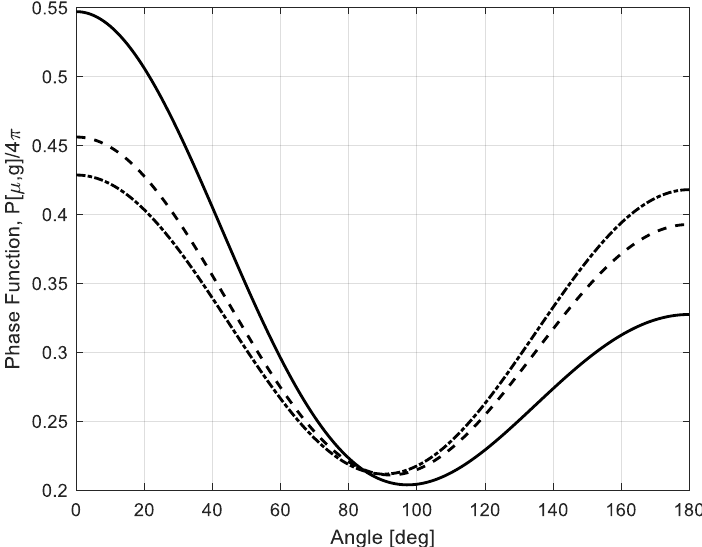
Figure 3. Phase function behavior for different particle radii: r = 60 μm (dash -dot − ∙ ), r = 150 μm (dashed line ‒ ‒ ), r = 300 μm (solid line ― ); 94 GHz and brownout desert particles with dielectric constant ε = 5.5 − j5.15 × 10 −2 .